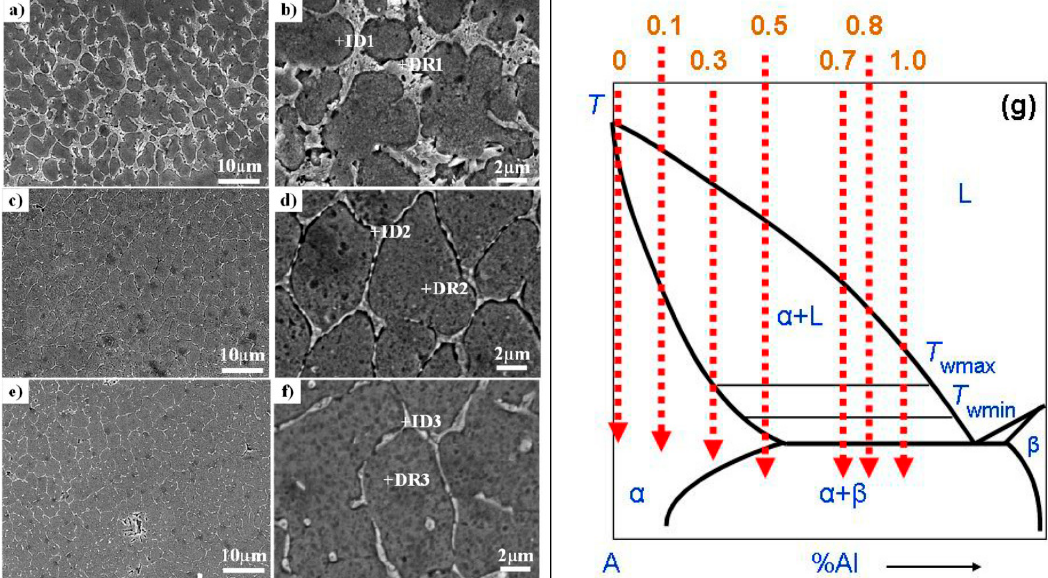
Figure 8. The microstructure of coatings with medium Al content. ( a ) Al 0.7 CrFeCoNiCu. ( b ) is the enlarged image for Figure 8a. ( c ) Al 0.8 CrFeCoNiCu. ( d ) is the enlarged image for Figure 8c. ( e ) Al 1.0 CrFeCoNiCu. ( f ) is the enlarged image for Figure 8e. ( g ) Schematic phase diagram with GB wetting tie-lines. The dotted red arrows with Al concentrations on the top show the cooling trajectories corresponding to the micrographs in Figures 7 and 8. Micrographs ( a – f ) are reprinted with permission from Ref. [64]. Copyright 2021 Elsevier.